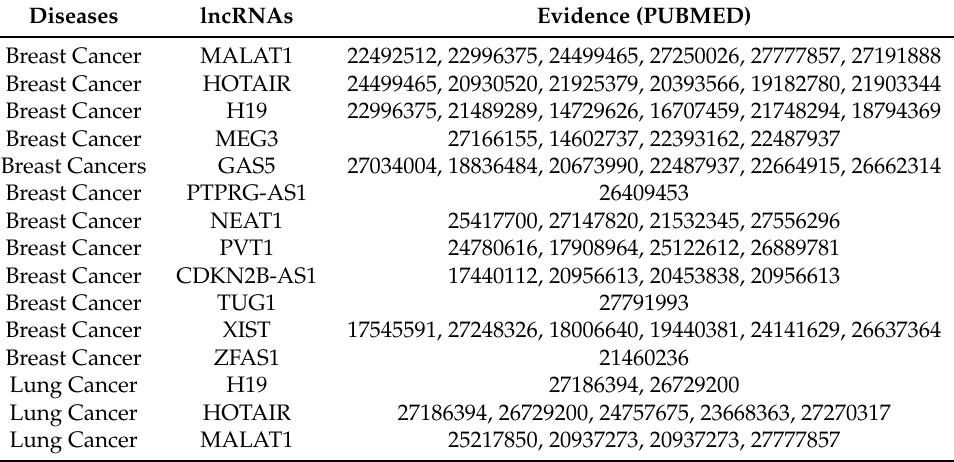
Table 3. The experimentally confirmed lncRNAs in the top 20 potential lncRNAs predicted by PMFILDA in three kinds of case